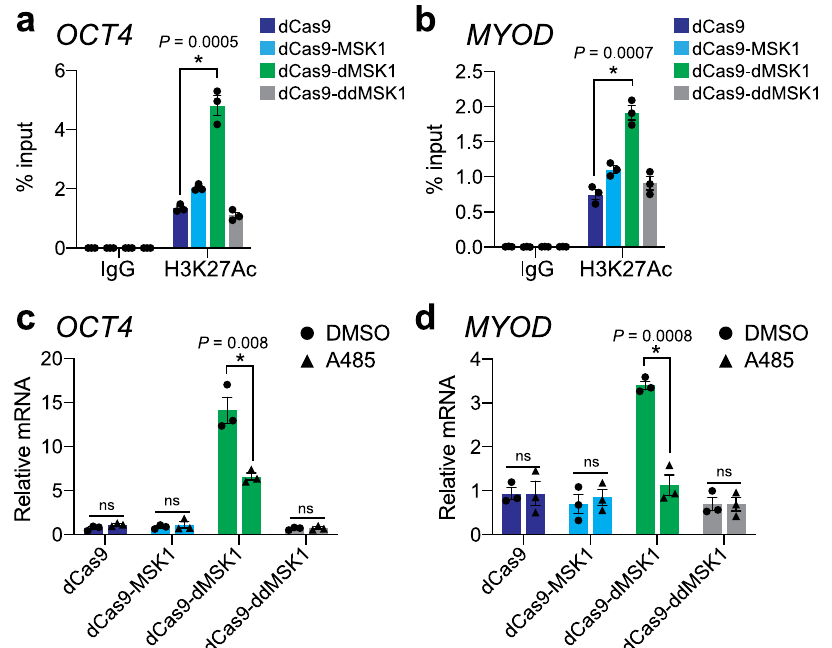
Fig. 5 dCas9-dMSK1 in fl uences H3K27 acetylation status at targeted human promoters. a , b ChIP-qPCR enrichment for H3K27ac at the OCT4 (panel a ) or MYOD (panel b ) promoters 72 h post-transfection of dCas9 or indicated dCas9-fusion protein and corresponding gRNAs. c , d RT-qPCR for OCT4 (panel c ) or MYOD (panel d ) in the presence of DMSO or the CBP/p300 inhibitor A485 72 h post-transfection of dCas9 or indicated dCas9-fusion protein and corresponding gRNAs. 20 µ M of A485 or an equal volume of DMSO was added to cells 12 h post-transfection. Two-sided t -test, * P < 0.05; n = 3 independent experiments for all panels; error bars, s.e.m.; ns, not signi fi cant. Source data are available in the Source data fi